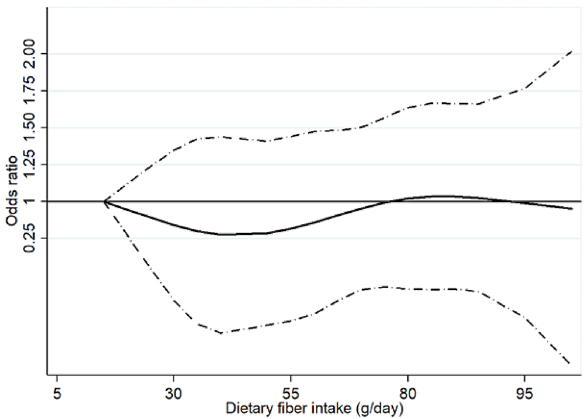
Figure 1. Relation between dietary fiber intake and metabolic syndrome in adult cancer survivors in the Korea National Health and Nutrition Examination Survey VI and VII (2013–2018), fitted with restricted cubic splines. The curves above are adjusted for sociodemographic (age, sex, education level, household income), health behavior (physical activity, cigarette smoking, alcohol consumption) and nutritional status (total energy